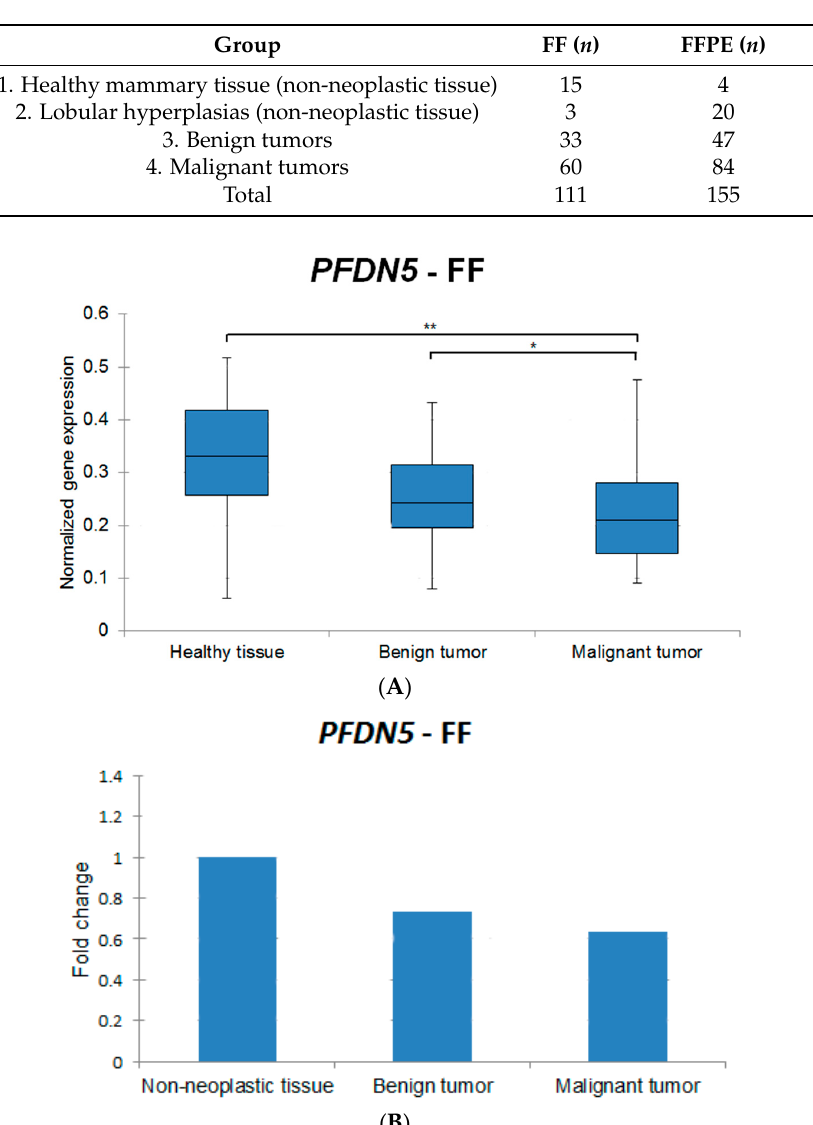
Figure 1. ( A ) Exemplary box plot indicating the normalized gene expression of PFDN5 in fresh frozen samples in the different histologic groups. Statistically significant differences are indicated by an asterisk (*). Results are classified as significant (* p < 0.05) and very significant (** p < 0.01). The box includes cases from the 25th to the 75th percentile. The horizontal line within the box represents the median and the upper and lower bars are the largest and lowest observed values. Significant differences are revealed between the groups healthy tissue vs. malignant tumors and benign tumors vs. malignant tumors; ( B ) Normalized expression fold changes (mean) indicating the percentage change of PFDN5 in fresh frozen samples in the different histologic groups.